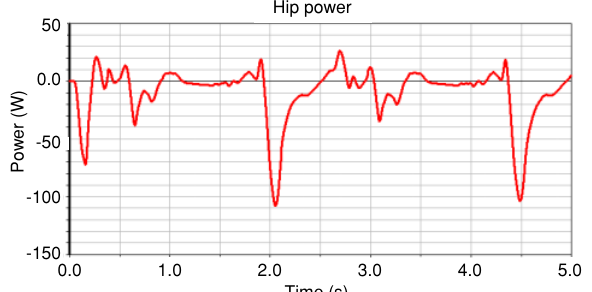
Figure 18 Hip instantaneous mechanical power.